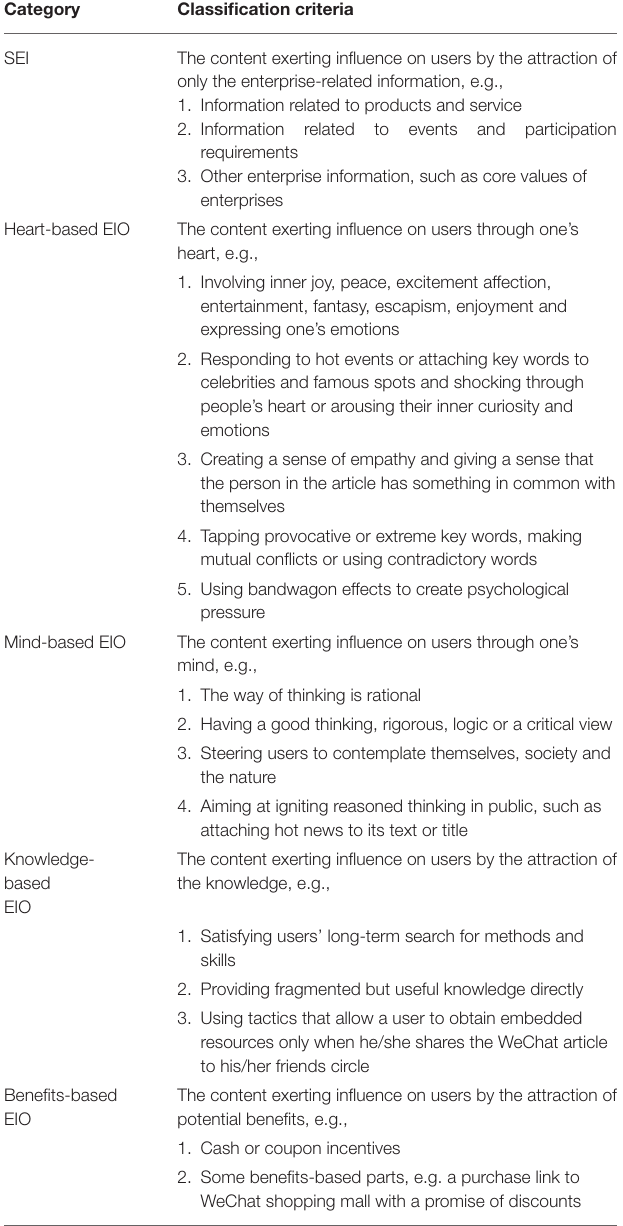
TABLE 1 | The classification criteria of